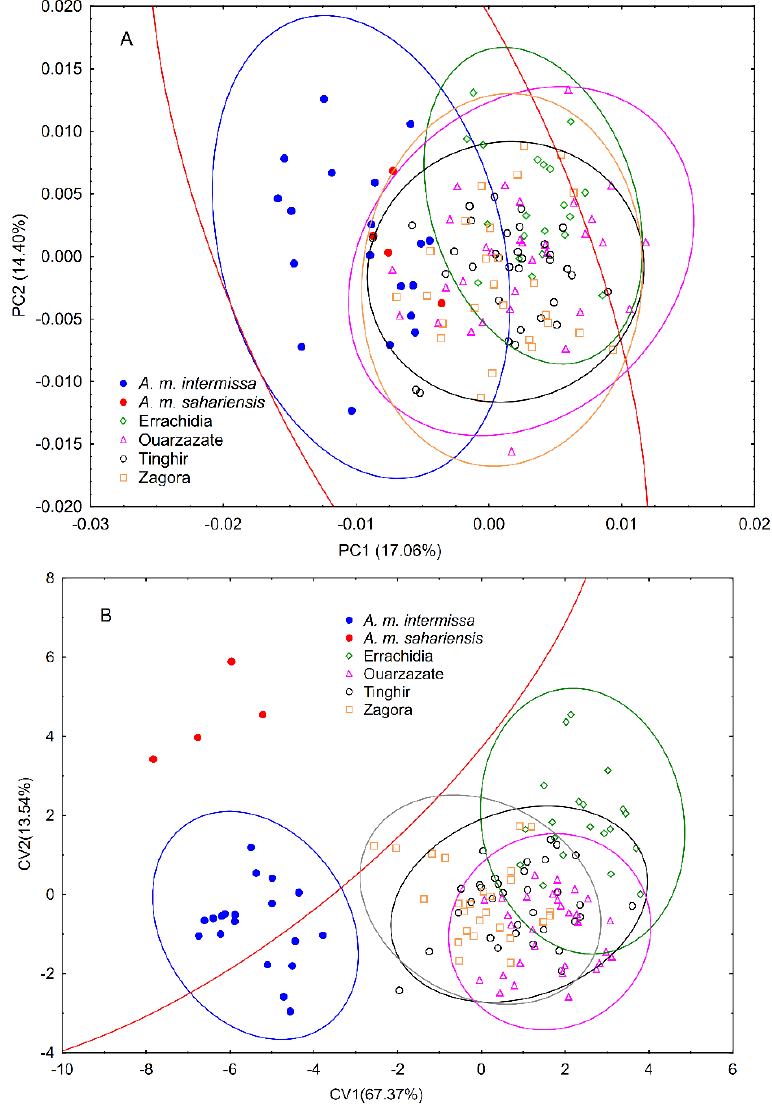
Figure 2. Variation of wing shape of honey bees in four areas of south-eastern Morocco in compar-ison to reference samples of A. m. sahariensis and A. m. intermissa illustrated with the first two prin-cipal components ( A ) and first two canonical variates ( B ). Each marker represents the mean scores of each colony. The ellipses represent 95% confidence intervals around the centroid of each data cluster. Table 1. Mahalanobis distances (lower triangle) and significance of pair-wise statistical differences (upper triangle) in wing shape of honey bees from four areas of south-eastern Morocco and refer- ence samples of A. m. sahariensis and A. m. intermissa .